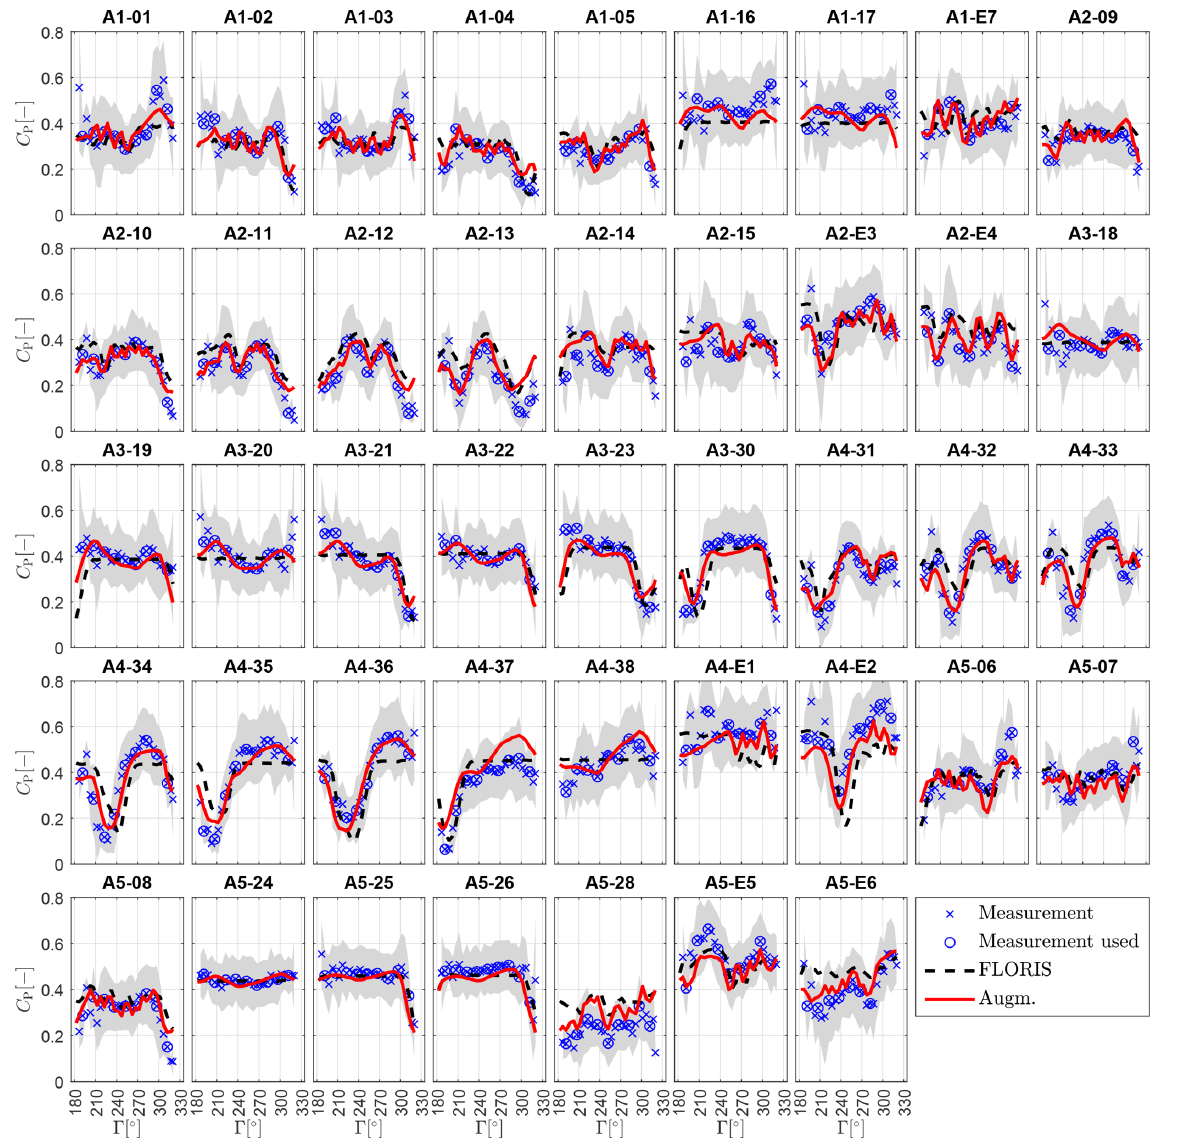
Figure 17. Power coefficient of each individual wind turbine, as indicated by the subplot title, as a function of wind direction (cid:48) for wind speeds V ∈ [ 8 , 10 ] ms − 1 . The gray shaded area indicates the standard deviation within the binned measurements. The number of measure- ments within each bin is reported in Fig.